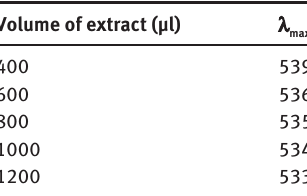
Table 2 Influence of extract